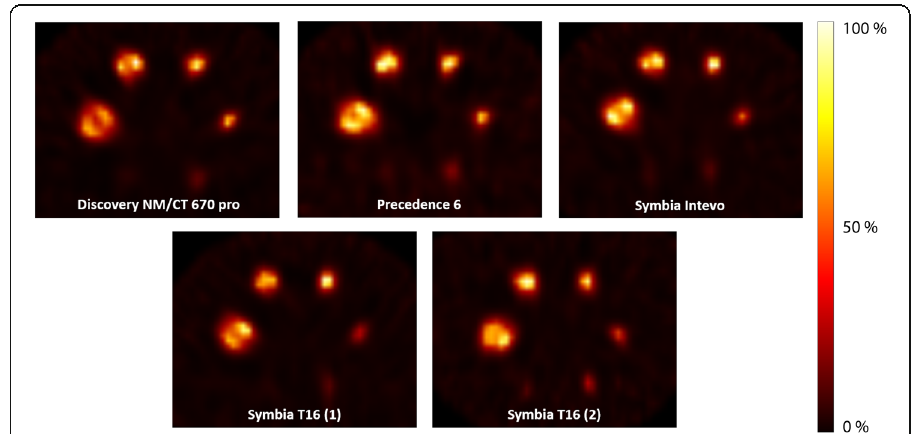
Fig. 4 Images of the NEMA IEC body phantom for all systems, reconstructed with a vendor-neutral